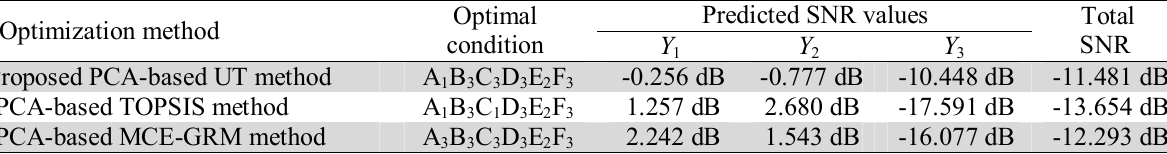
Table 14 Predicted SN ratios at the optimal conditions derived by the three methods Optimization